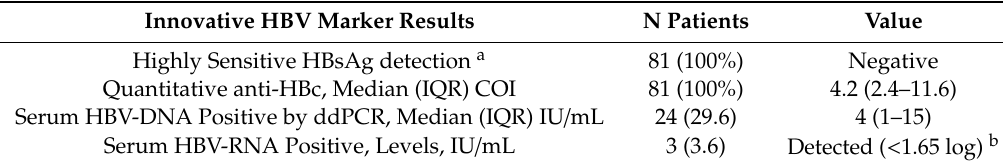
Table 2. Results of novel serological and molecular HBV markers in the study population. Innovative HBV Marker